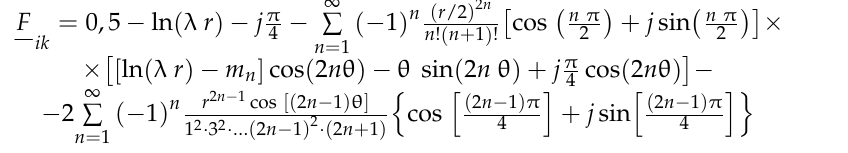
Phase coordinates are the most natural description of three-phase power